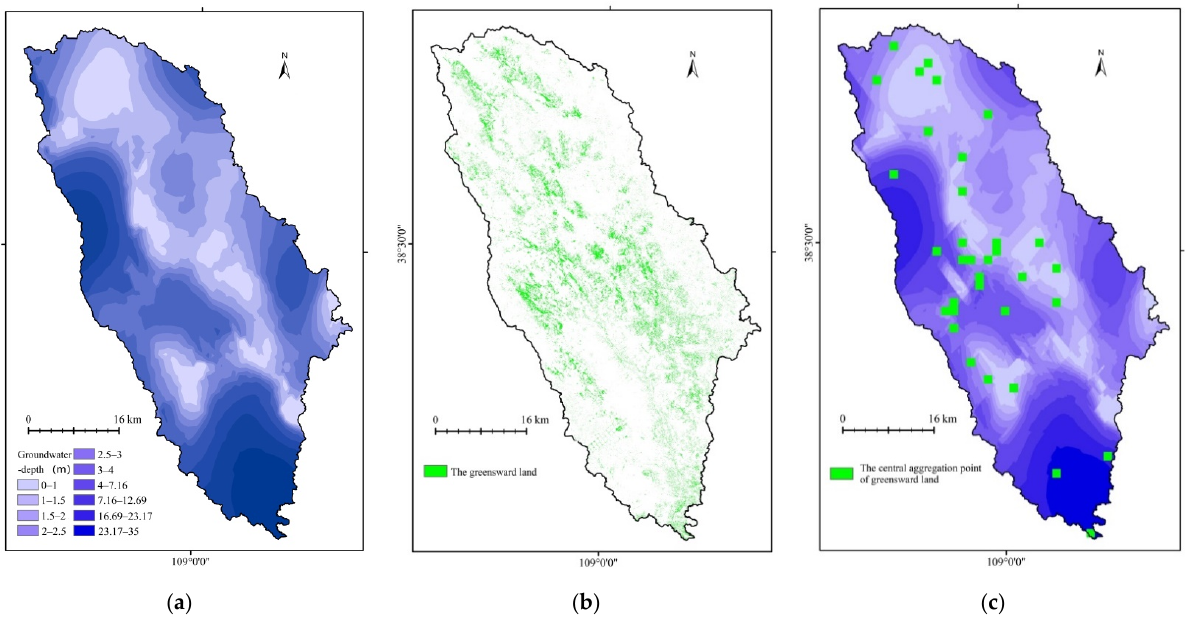
Figure 8. ( a ) Interpolation of groundwater depth in the watershed; ( b ) Distribution of greensward land use type in the watershed; ( c ) Location of the center of greensward land in the watershed (colors of the groundwater flow field are illuminated for